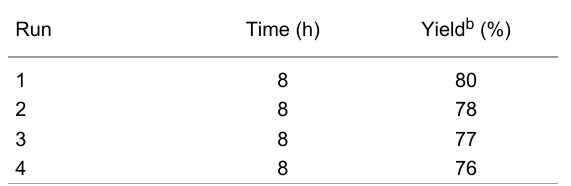
ponds to good yields with a short reaction time in comparison to aryl halides having electron donating groups (Figure 2).